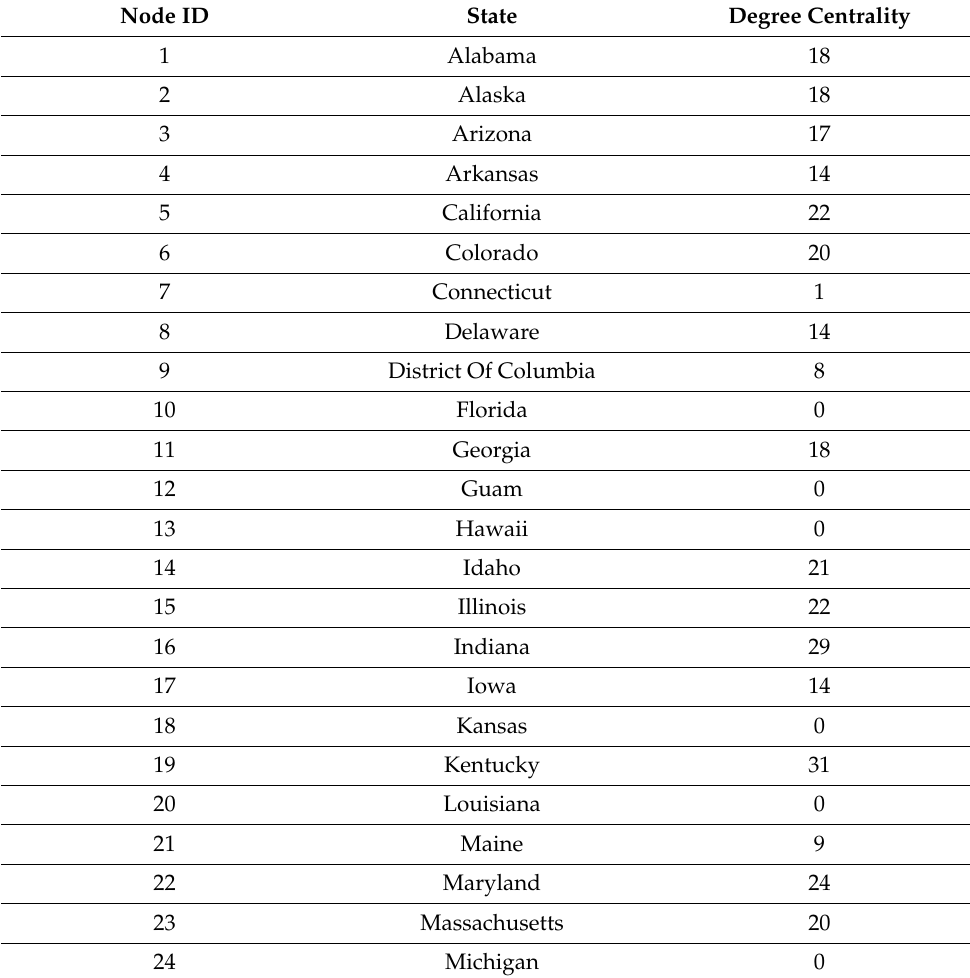
Table 3. Degree centrality of states in the